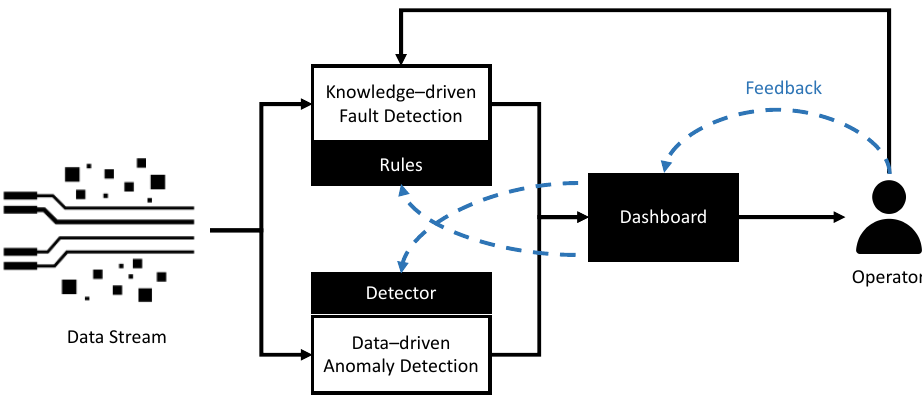
Figure 2. Overview representing how data- and knowledge-driven techniques can be combined in an anomaly and/or fault detection